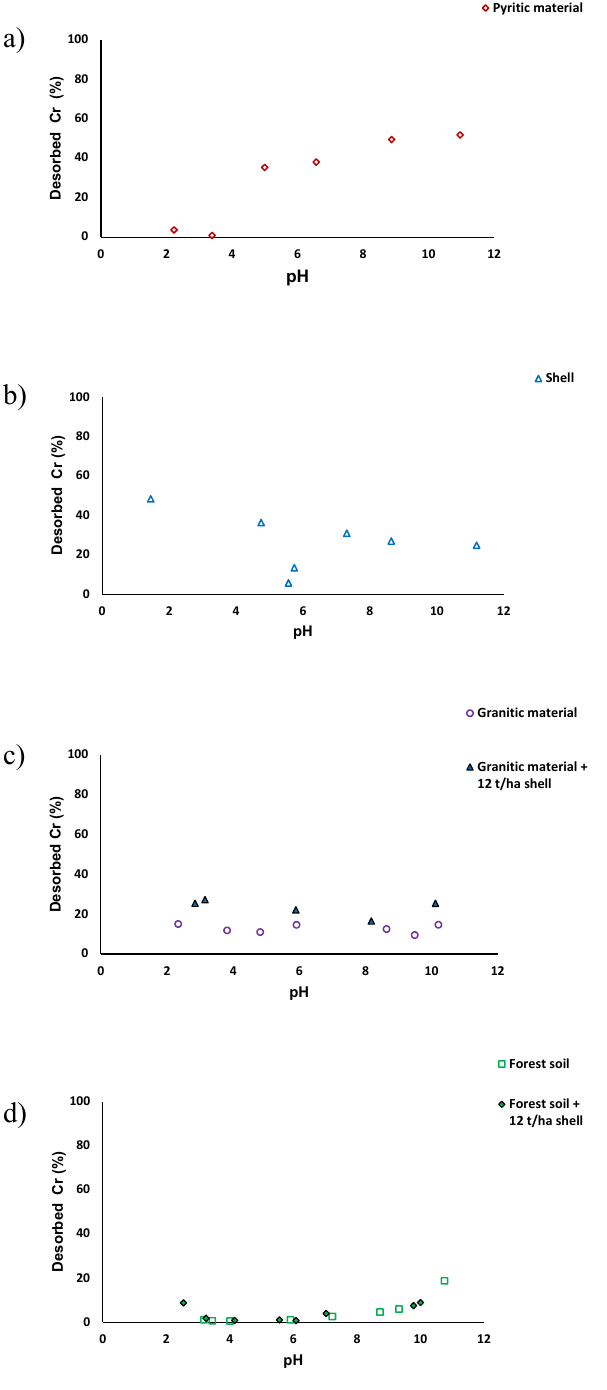
Figure 3. Relation between desorbed Cr(VI) (%) and pH for pyritic material (a) , mussel shell (b) , amended and unamended granitic ma- terial (c) , and amended and unamended forest soil (d) , after being added with 100mgL − 1 Cr. Mean values; triplicate samples with coefficient of variation <5%.